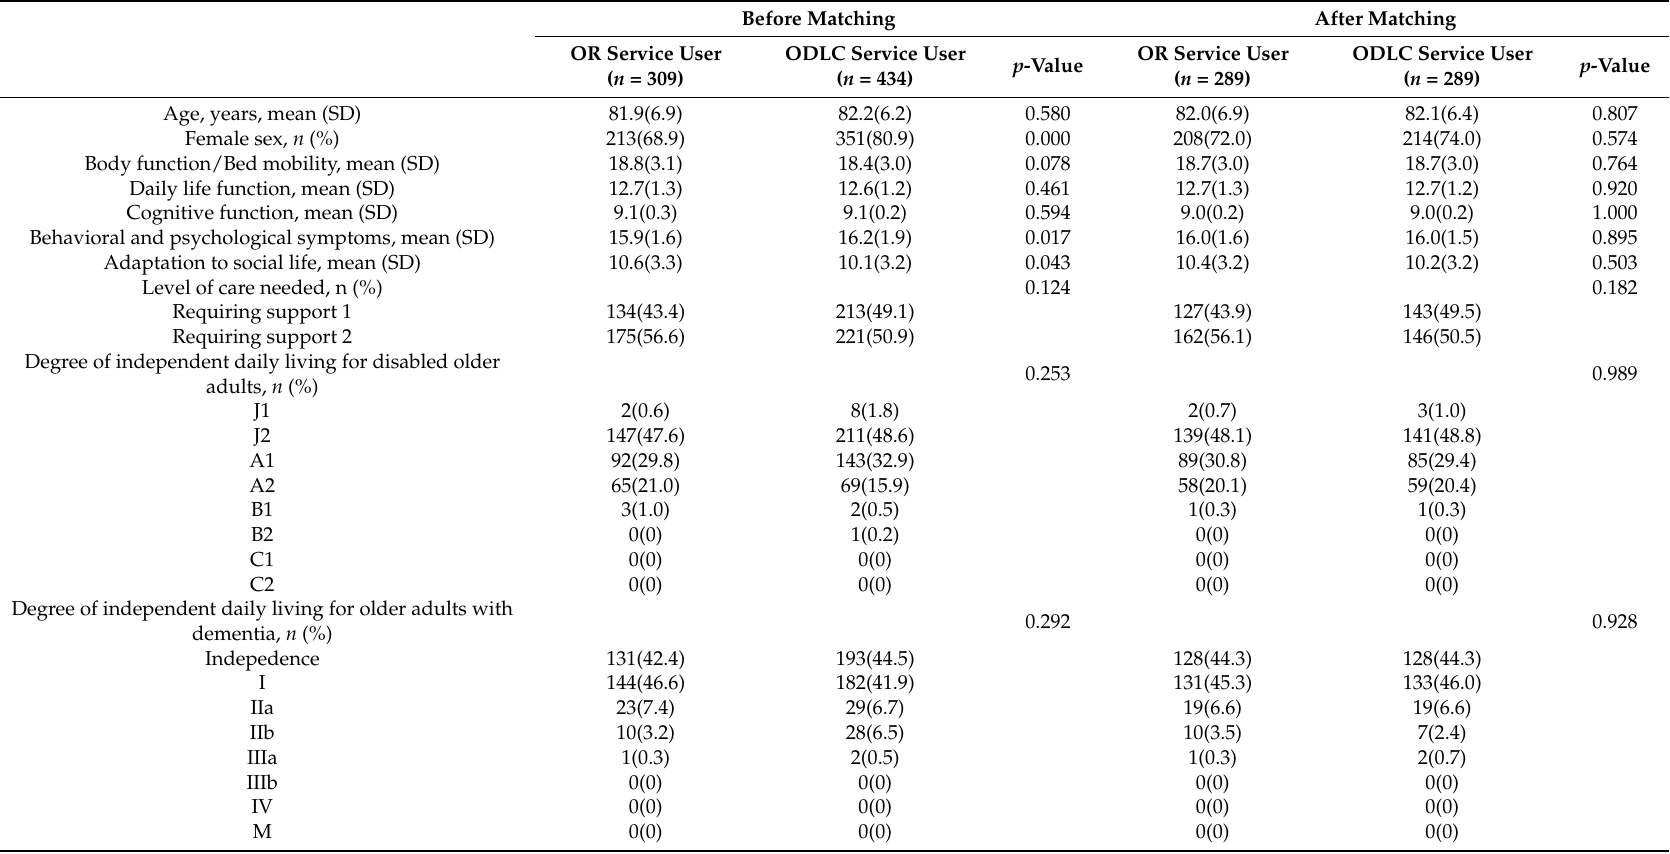
Table 2. Sample characteristics before and after propensity score matching in older adults requiring